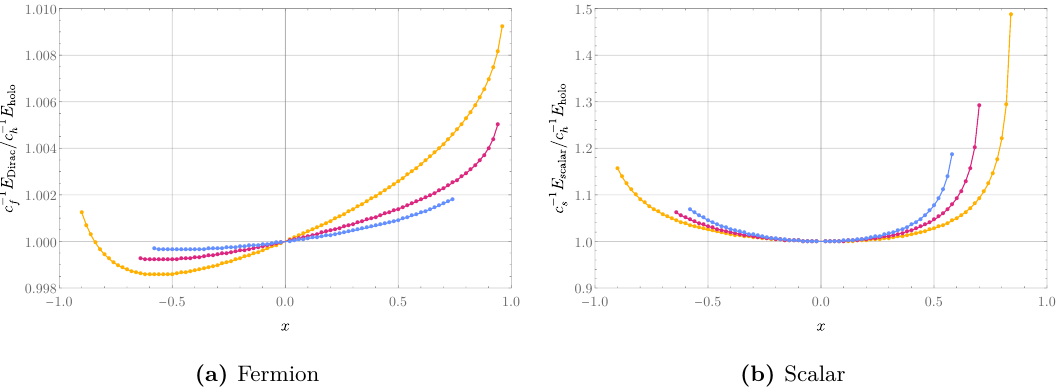
Figure 7 . The ratio between the Casimir energy of the holographic CFT and the free fields on the geometries (2.7); orange, magenta, and blue correspond to n = 1 , 2, and 3, respectively. Note that the variation between the Dirac fermion and the holographic CFT is less than ∼ 1 % for all the deformations shown here, while the variation between the scalar and the holographic CFT reaches up to ∼ 50 % for the most extreme